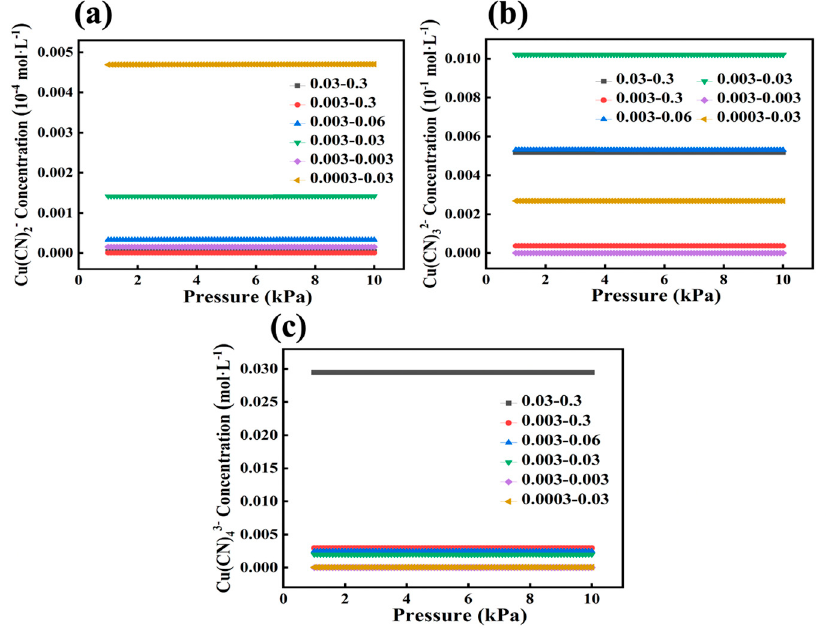
Figure 7. The OLI studio 11.0 simulates the concentration of ( a ) Cu(CN) 2 − , ( b ) Cu(CN) 32 − and ( c ) Cu(CN) 43 − in the system under different pressures for six different concentration gradients.